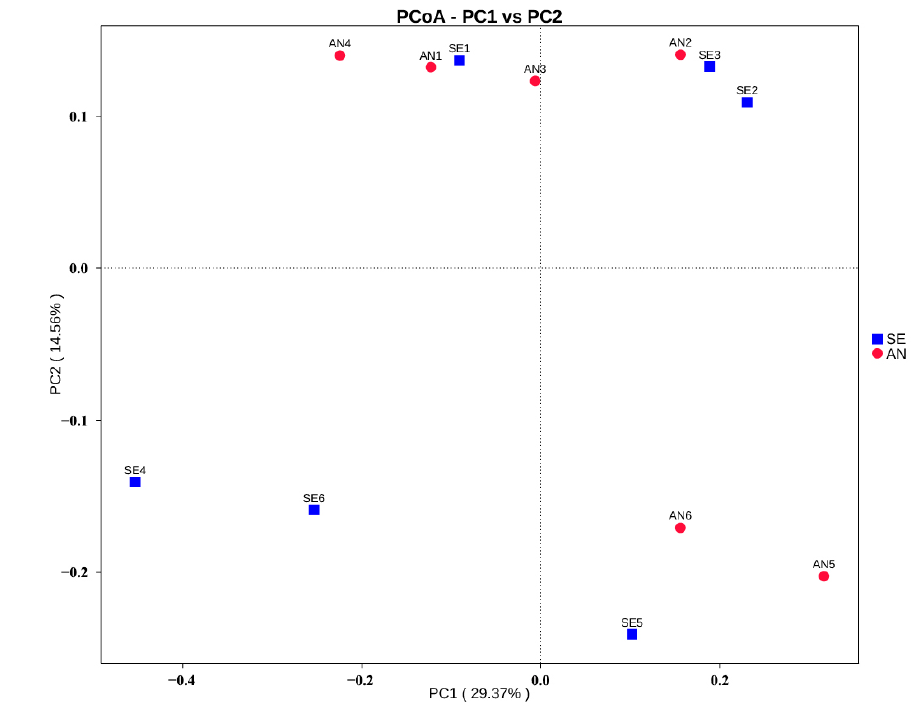
Figure 6. Principal coordinate analysis (PCoA) plot of the microbiota structure between AN (red) and SE (blue) samples.